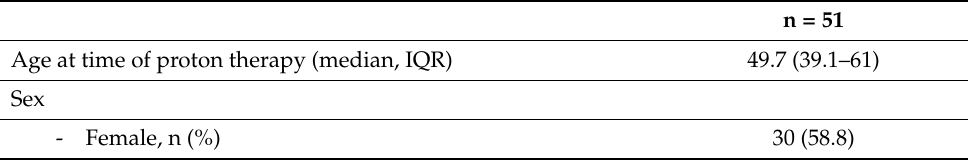
Table 1. Patients, treatment, and follow-up characteristics (n =